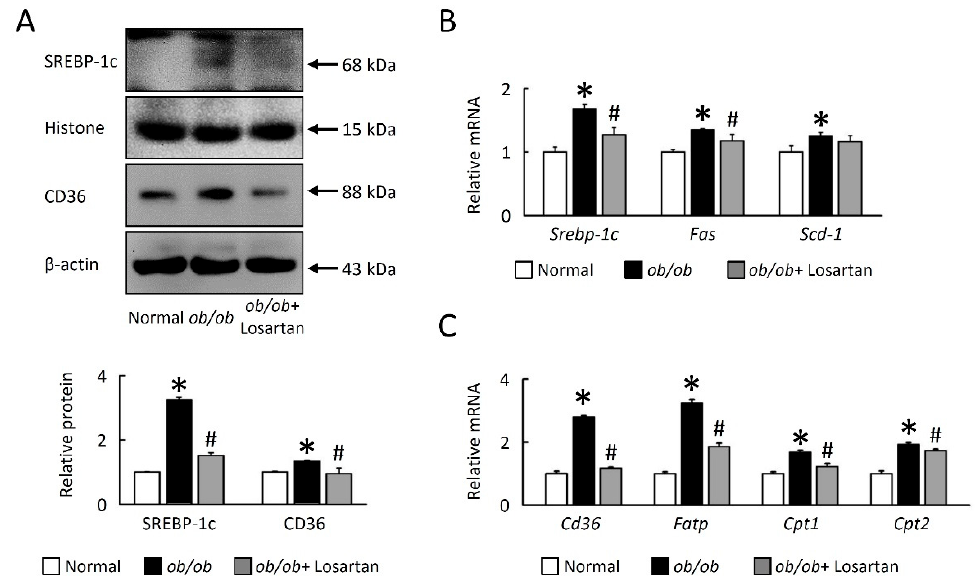
Figure 2. Losartan attenuates lipogenesis in EWAT. Quantification of ( A ) SREBP-1c, Histone, CD36, and β -actin protein levels by Western blot. Below graph indicate quantification relative to Histone/ β -actin. Quantification of ( B ) Srebp-1c , Fas , Scd-1 , ( C ) Cd36 , Fatp , Cpt1 , and Cpt2 by qRT-PCR. qRT-PCR indicates quantification relative to Gapdh . For each animal group, n = 5. All values represent the mean ± SEM. Data were analyzed by Student’s t test. * p ≤ 0.05, normal vs. ob/ob ; # p ≤ 0.05, ob/ob vs. ob/ob + Losartan. Srebp-1c : sterol regulatory element-binding protein 1c; Fas : fatty acid synthase; Scd-1 : stearoyl-CoA desaturase-1, Fatp : fatty acid transport protein; Cd36 : cluster of differentiation 36; Cpt1 : carnitine palmitoyltransferase 1.